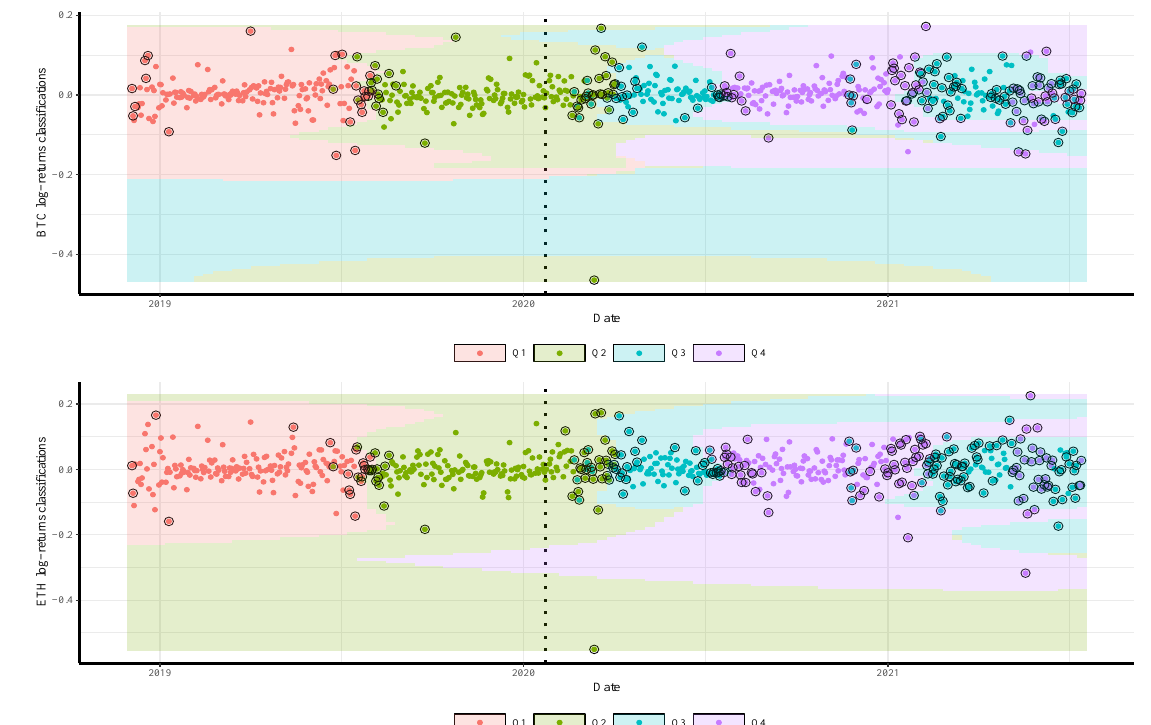
Figure 5. Classifications of BTC ( top ) and ETH ( bottom ) daily returns based on quartiles of daily gold prices predicted by the SVM model. The vertical dotted line represents the threshold between the pre-COVID-19 period ( left ) and ongoing COVID-19 period ( right ) to visualize its impact on the cryptocurrency return.